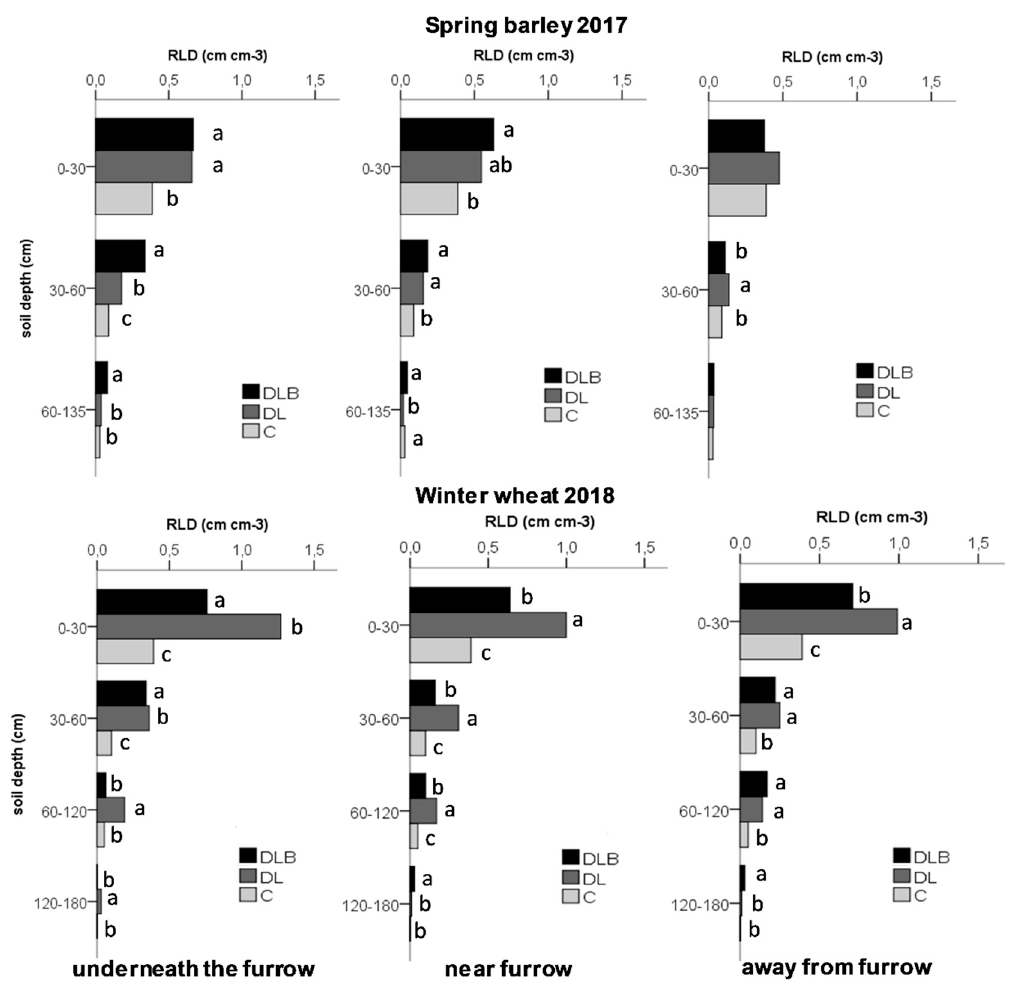
Figure 3. Mean root-length density of three soil depth classes (2017) and four soil depth classes (2018). From left to right: directly underneath the furrow, near the furrow (up to 20 cm distance) and away from the furrow (2017: 20–85 cm distance, 2018: 20–35 cm distance). Different letters indicate significant differences (Kruskal–Wallis test followed by Dunn–Bonferroni correction, p < 0.05). C: control, DL: deep loosening with tine, DLB: deep loosening with tine and bio compost, RLD: root-length density.